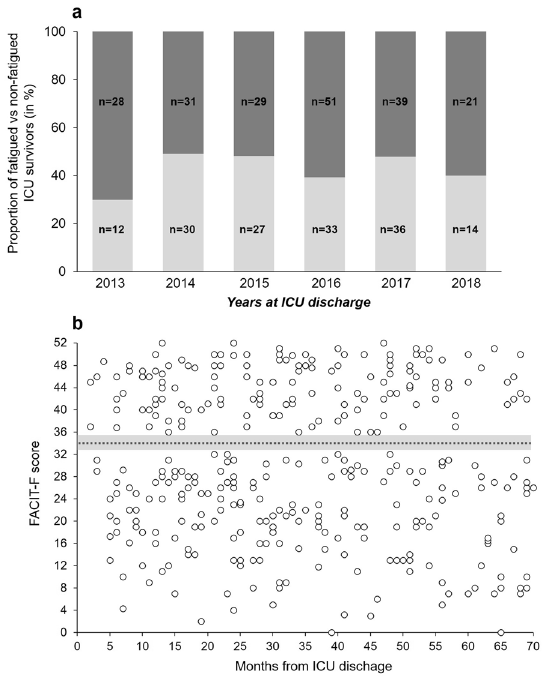
Figure 2. Fatigue prevalence in ICU survivors. ( a ) The proportion of fatigued (dark grey bar) versus non- fatigued (light grey bar) ICU survivors over the 5 years of the study period. ( b ) The FACIT-F scores of the 351 responders in connection with the number of months since ICU discharge. The dotted black line represents the cutoff point of fatigue (i.e. FACIT-F score = 34) proposed by Van Belle et al. 15 . Scores between 33 and 35 were ignored to clearly distinguish between fatigued and non-fatigued categories. These intermediate values are represented by the grey zone in ( b ).